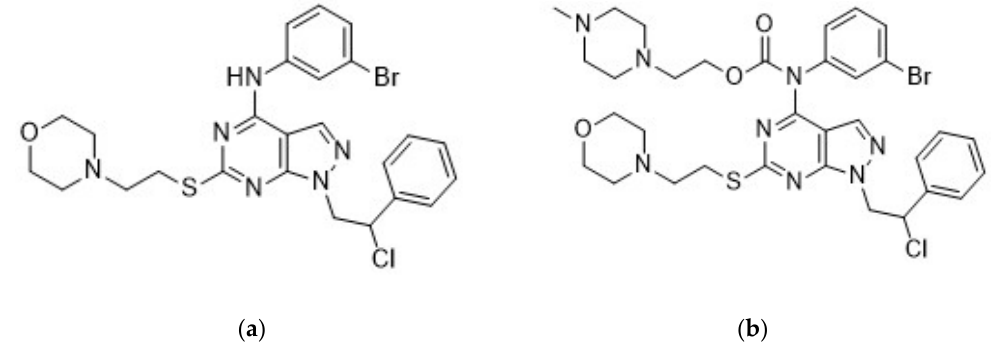
Figure 1. Molecular structure of Si306 ( a ) and pro-Si306 ( b ).